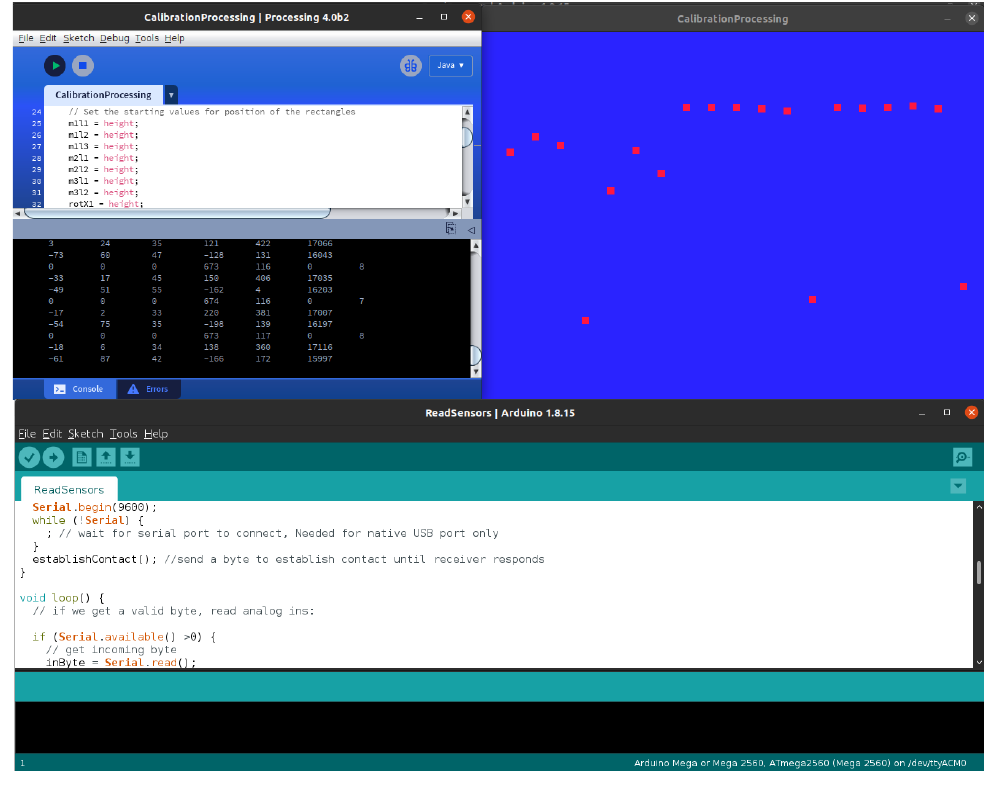
Figure 32. Processing calibration interface. Table 2. Calibration results with digital measurements and real measurements.